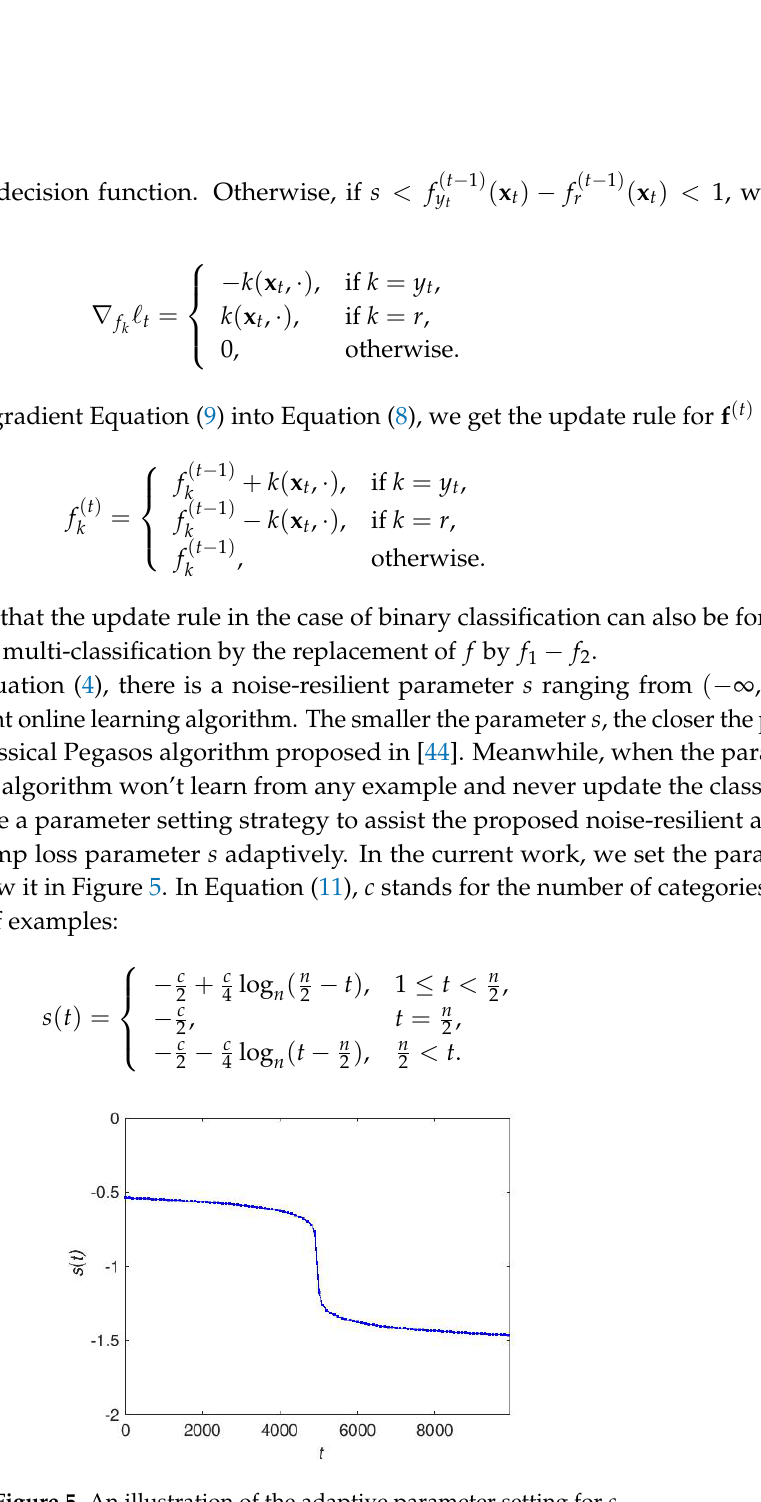
Figure 5. An illustration of the adaptive parameter setting for s